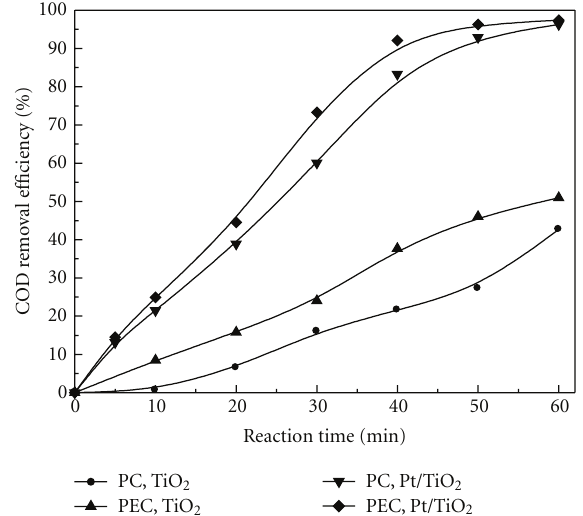
Figure 9: Dependence of COD removal e ffi ciency on treatment time for various processes.